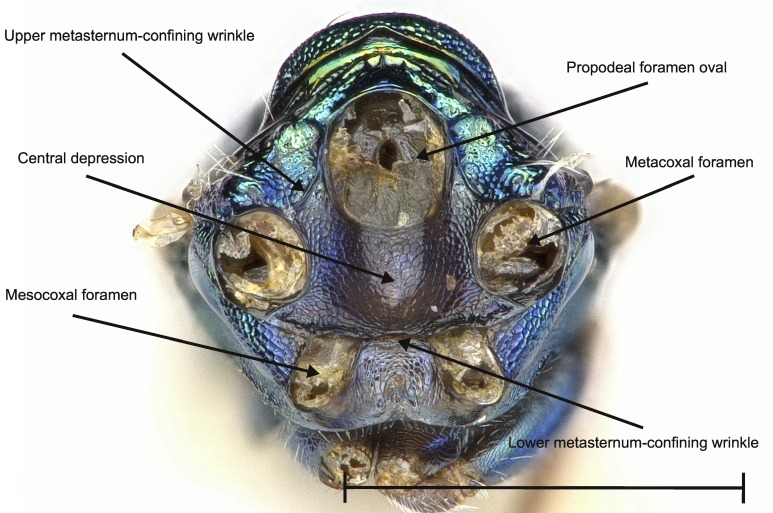
Pteromalus
caudiger.